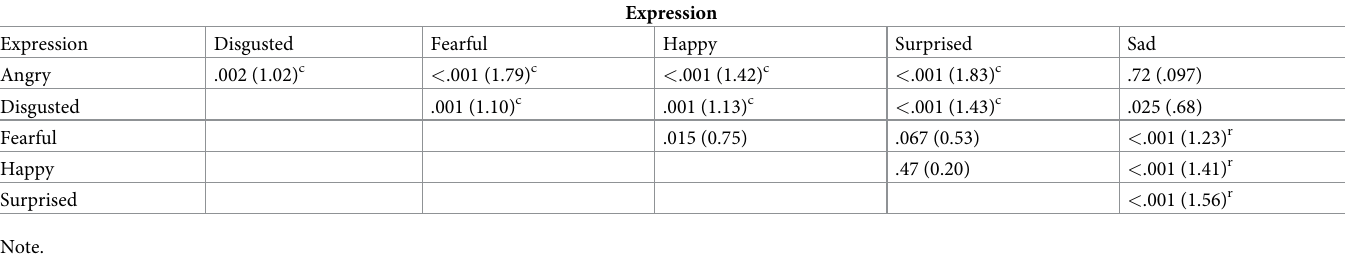
Table 4. P values (effect sizes in parentheses) from paired-sample t-tests between each pair of expressions collapsed across eccentricities, in the detection